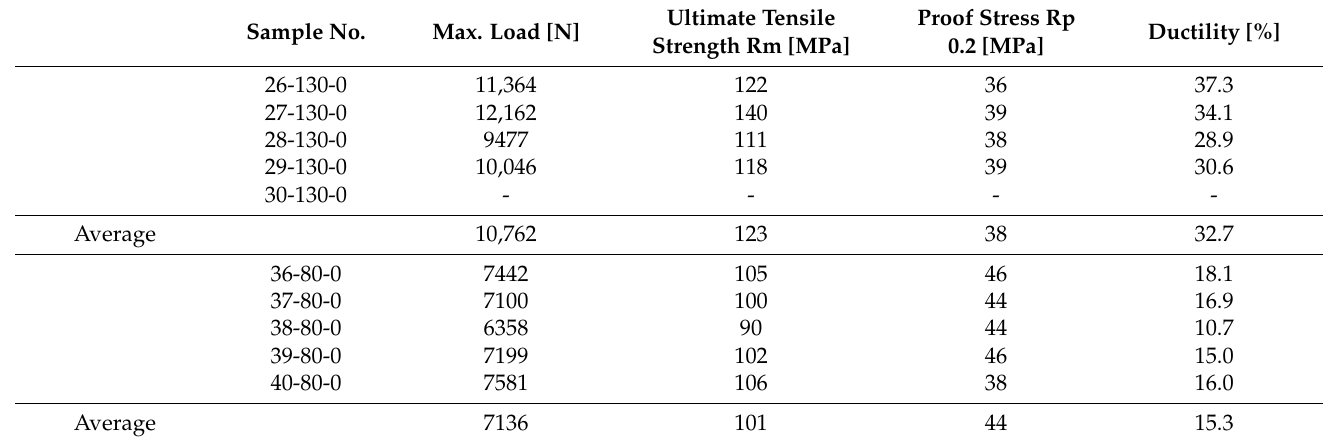
Table 1. Average values of mechanical parameters of the samples without an integrated RFID tag. Sample